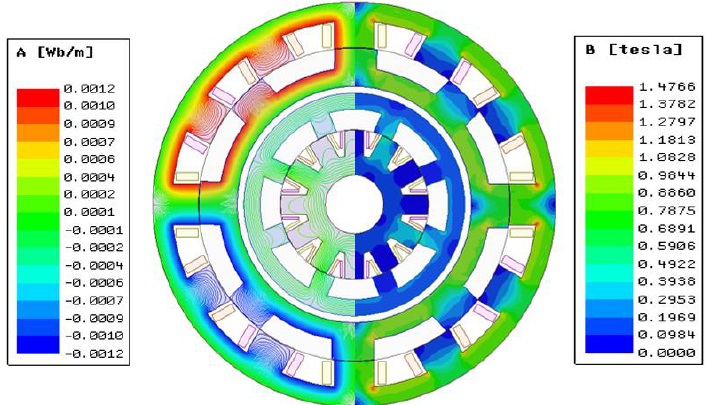
Figure 7. DDSRG magnetic induction line distribution and magnetic density cloud diagram.